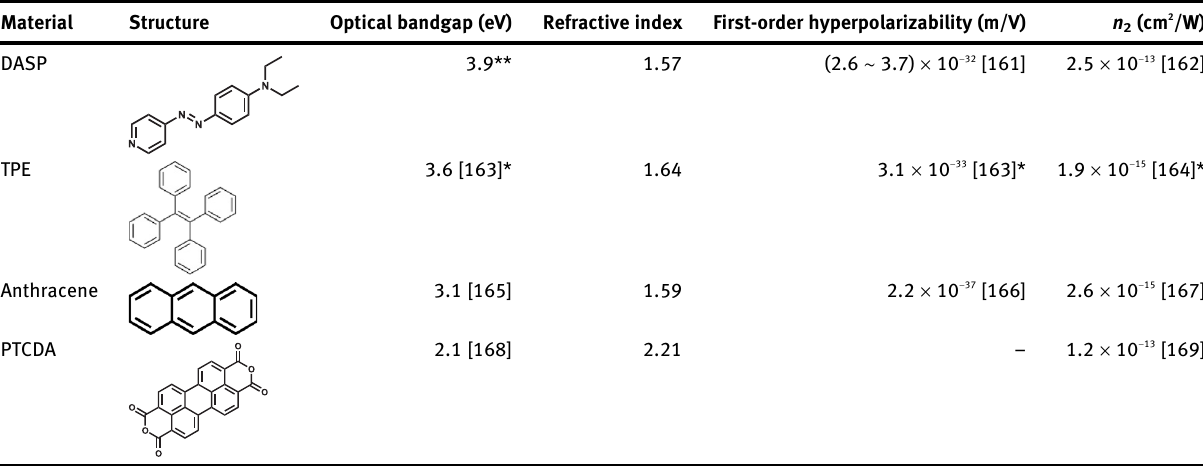
Table  : Nonlinear optical properties of several commonly used organic materials.